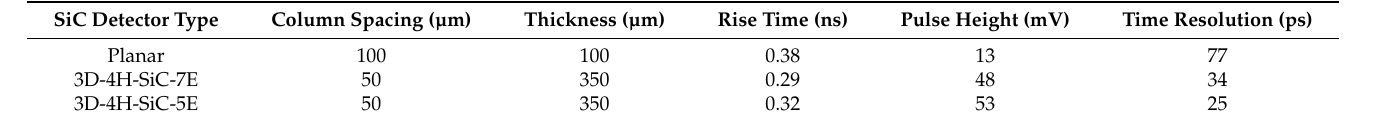
Table 1. The simulation parameters and results for planar 4H-SiC, 3D-4H-SiC-7E, and 3D-4H-SiC-5E detectors with 500 V bias voltage.